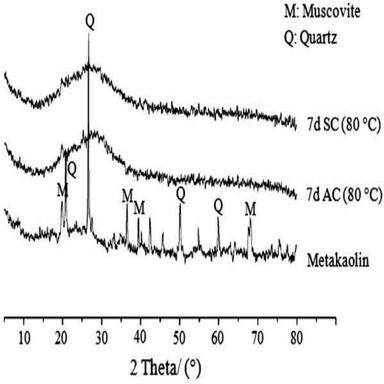
D patterns of metakaolin and geopolymer (Sc-Steam curing, AC-air curing)